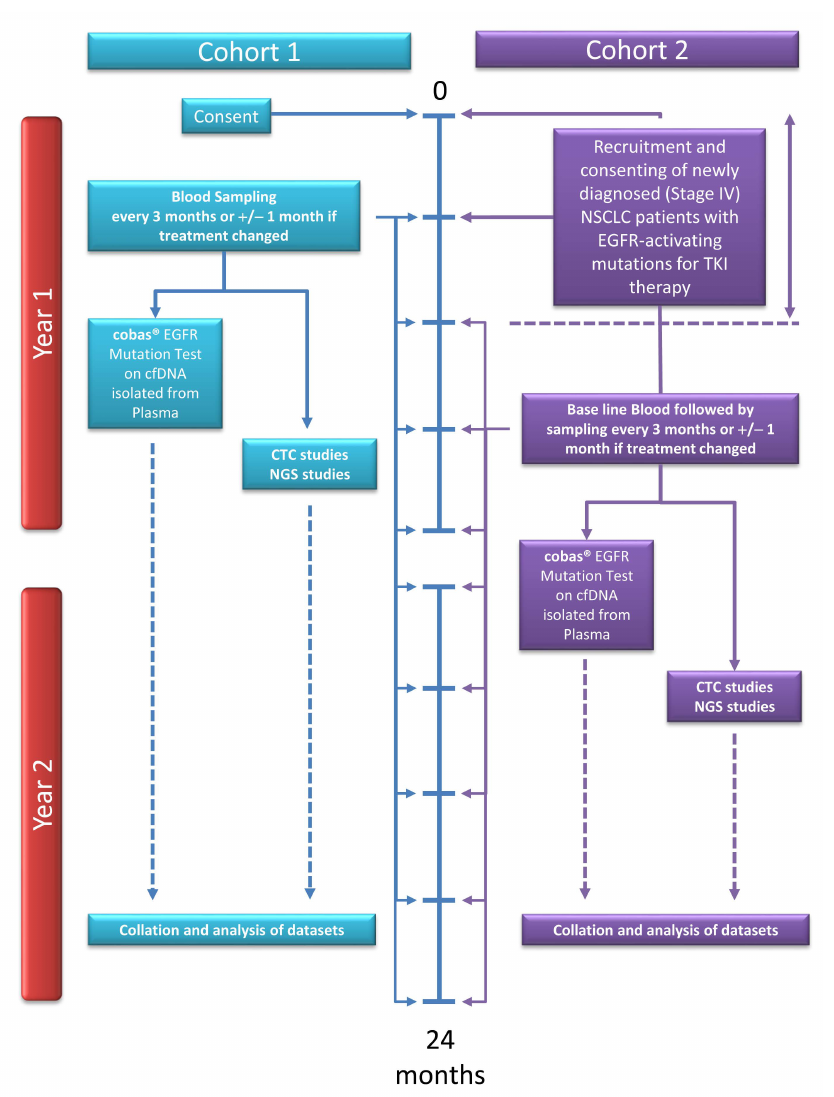
Figure 1. EGFR study design. A total of 21 patients with a confirmed tissue diagnosis of epidermal growth factor receptor ( EGFR ) mutated NSCLC were consented and enrolled on this two-year longitudinal study involving three participating Irish hospitals. Patients were stratified into one of two cohorts based on their treatment status: cohort 1 patients were consented during treat- ment with EGFR tyrosine kinase inhibitor (TKI) therapy, while cohort 2 patients were consented at diagnosis, prior to treatment. Liquid biopsy was collected every three months over two years. Plasma genotyping using cell-free DNA (cfDNA), circulating tumor cells (CTCs) and inflammatory markers derived from liquid biopsy at each time-point were examined and correlated with clinical